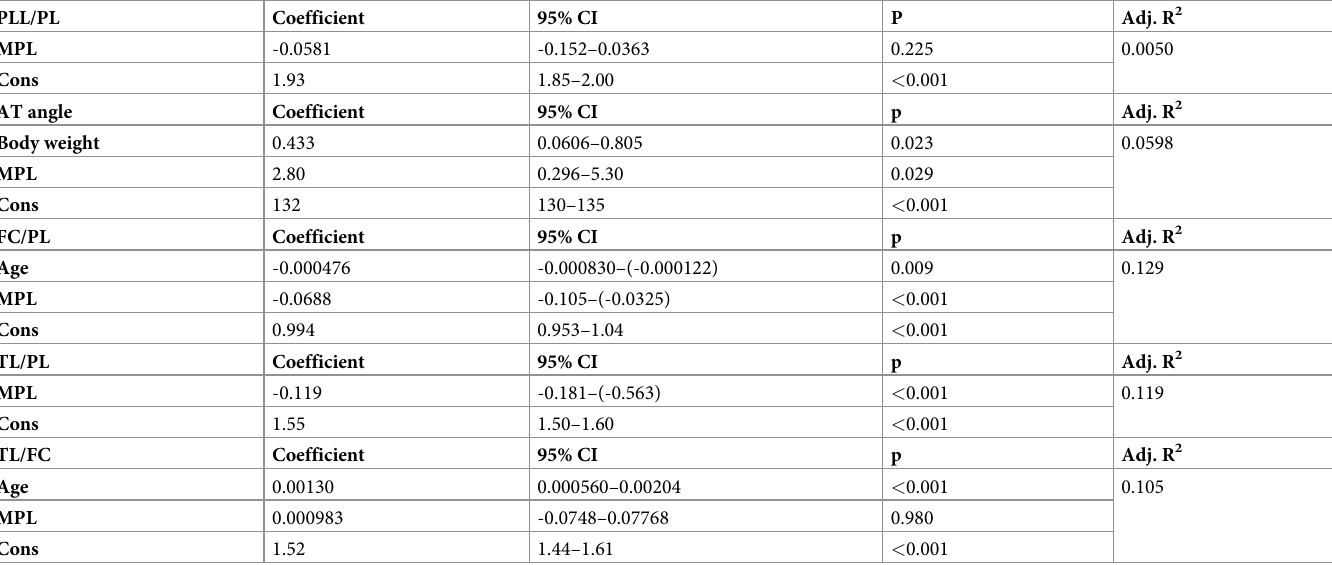
Table 7. Final models of multivariable linear regression analyses for PLL/PL, AT angle, FC/PL, TL/PL, or TL/FC, and the presence of